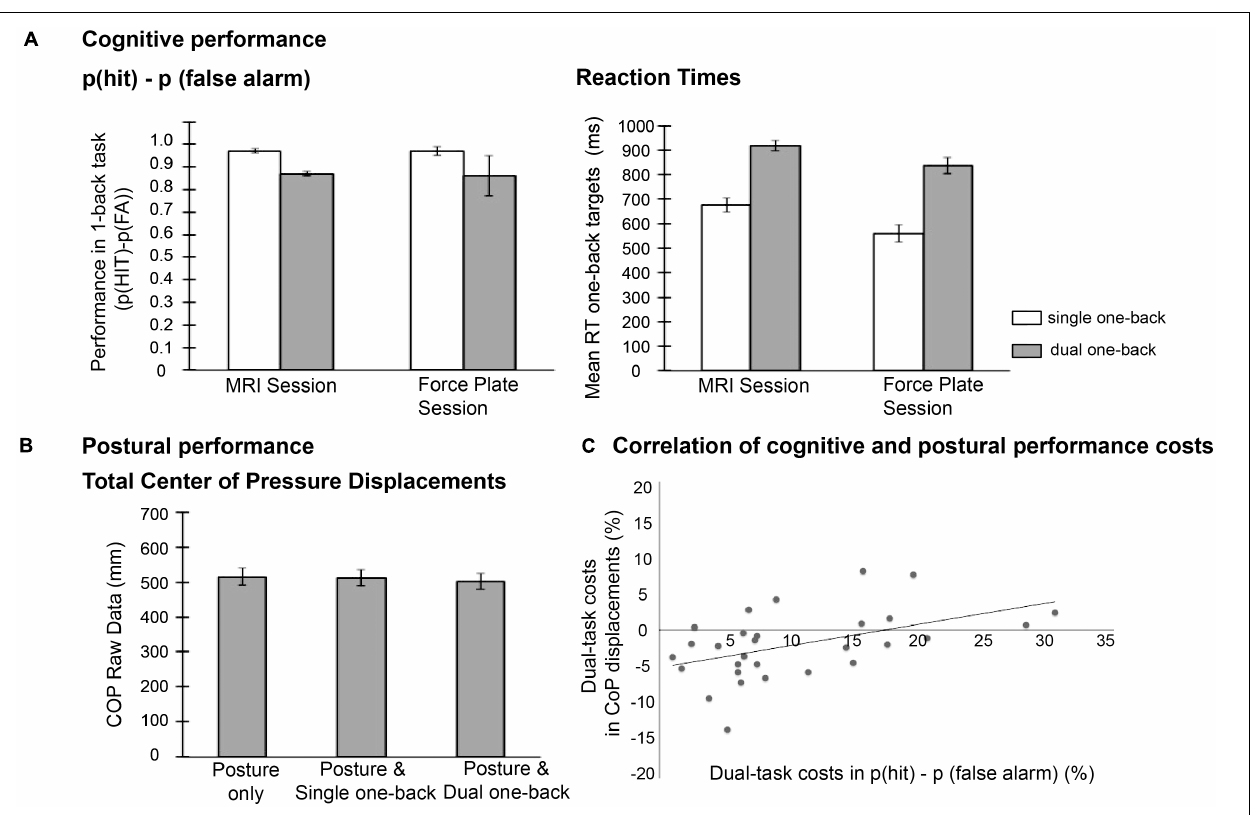
FIGURE 2 | (A) Mean cognitive performance data, (B) mean postural performance (raw data), and (C) correlation of performance costs in both